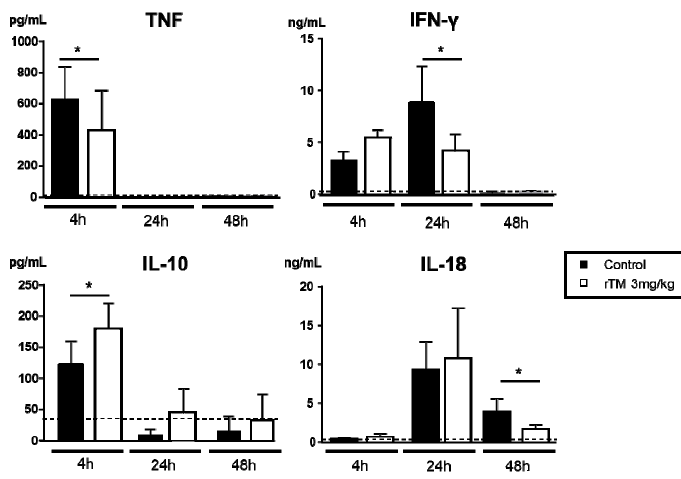
Figure 3. Effect of recombinant human soluble thrombomodulin (rTM) on the production of inflammatory cytokines after lipopolysaccharide (LPS) injection. Serum tumor necrosis factor (TNF), interferon (IFN)- γ , interleukin (IL)-10, and IL-18 production was measured as a biomarker of AKI at 0 (control and rTM, n = 3), 4 ( n = 7 and 6), 24 ( n = 4 and 5), and 48 h ( n = 5 and 6) before and after LPS-injection. The data are the mean values ± standard error of the mean (* p < 0.05, control versus rTM-treated